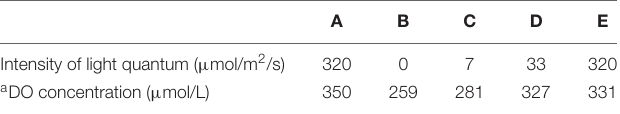
it remained at approximate 10% of the initial level and was 6% of the initial level at the end of the culture